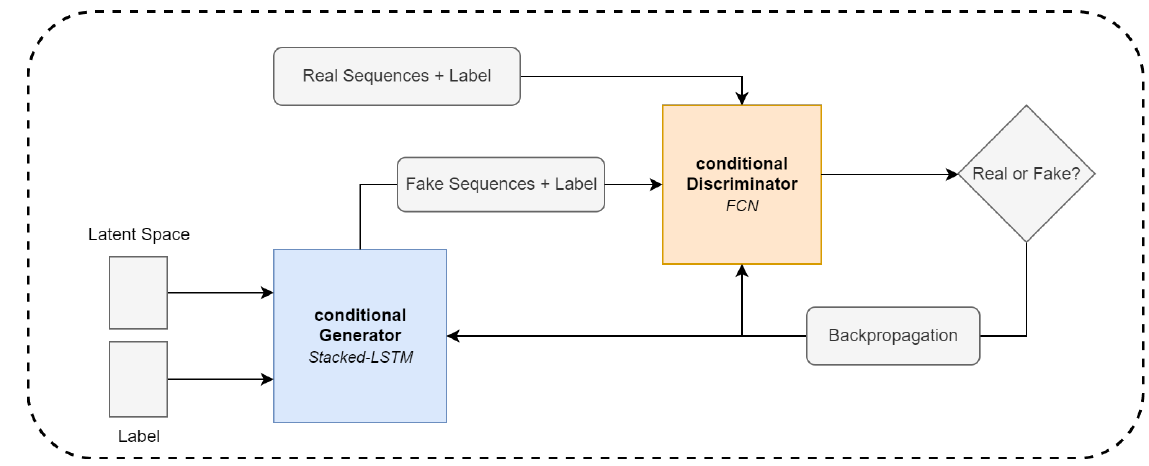
Figure 3. cGAN workflow.